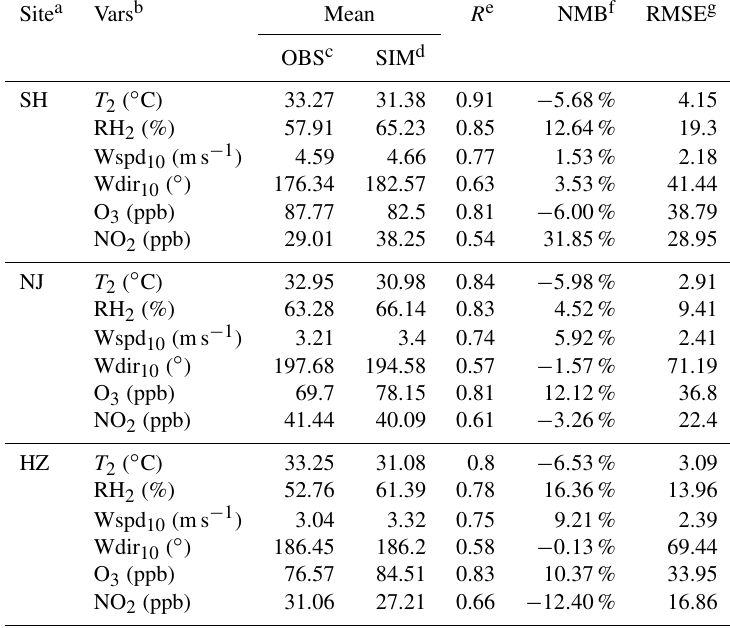
a Site indicates the city where the observation sites locate, including Shanghai (SH), Nanjing (NJ) and Hangzhou (HZ). b Vars indicates the variables under validation, including 2m air temperature ( T 2 ) , 2m relative humidity (RH 2 ) , 10m wind speed (Wspd 10 ) , 10m wind direction (Wdir 10 ) , ozone (O 3 ) and nitrogen dioxide (NO 2 ) . The words between the parentheses behind variables indicate the unit. c OBS indicates the observation data. d SIM indicates the simulation results from WRF/CMAQ. e R indicates the correlation coefficients, with statistically significant at 95% confident level. f NMB indicates the normalized mean bias. g RMSE indicates the root-mean-square